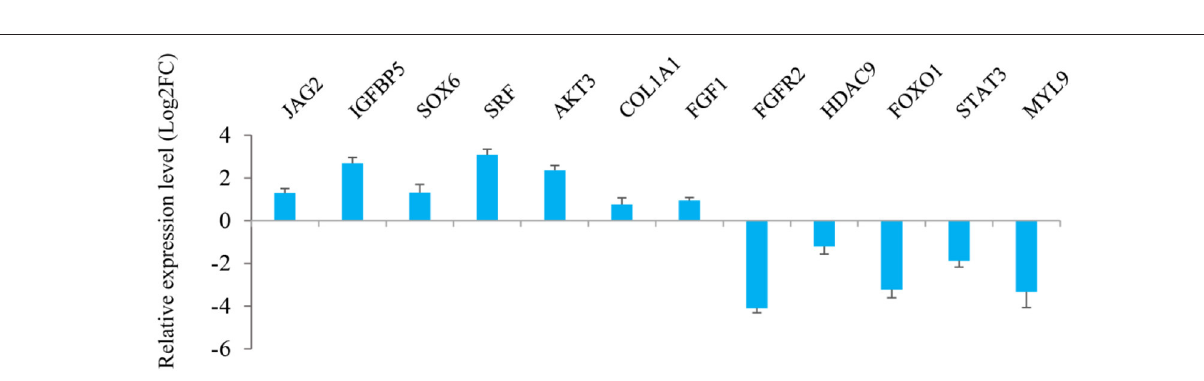
FIGURE 4 | Relative expression level of the target genes of 12 miRNAs selected in Longissimus dorsi muscle between Liaoning cashmere (LC) and Ziwuling black (ZB) goats detected using